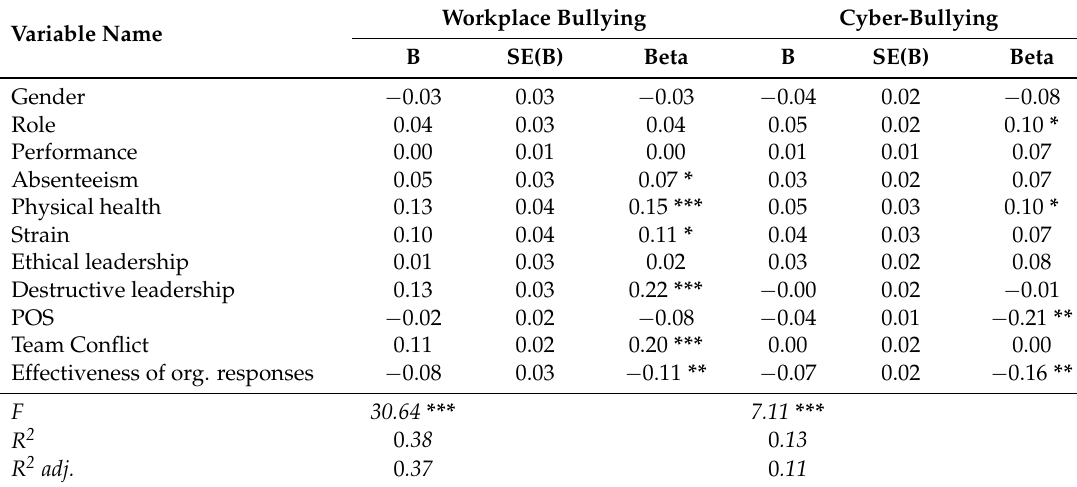
Table 2. Regression tests of